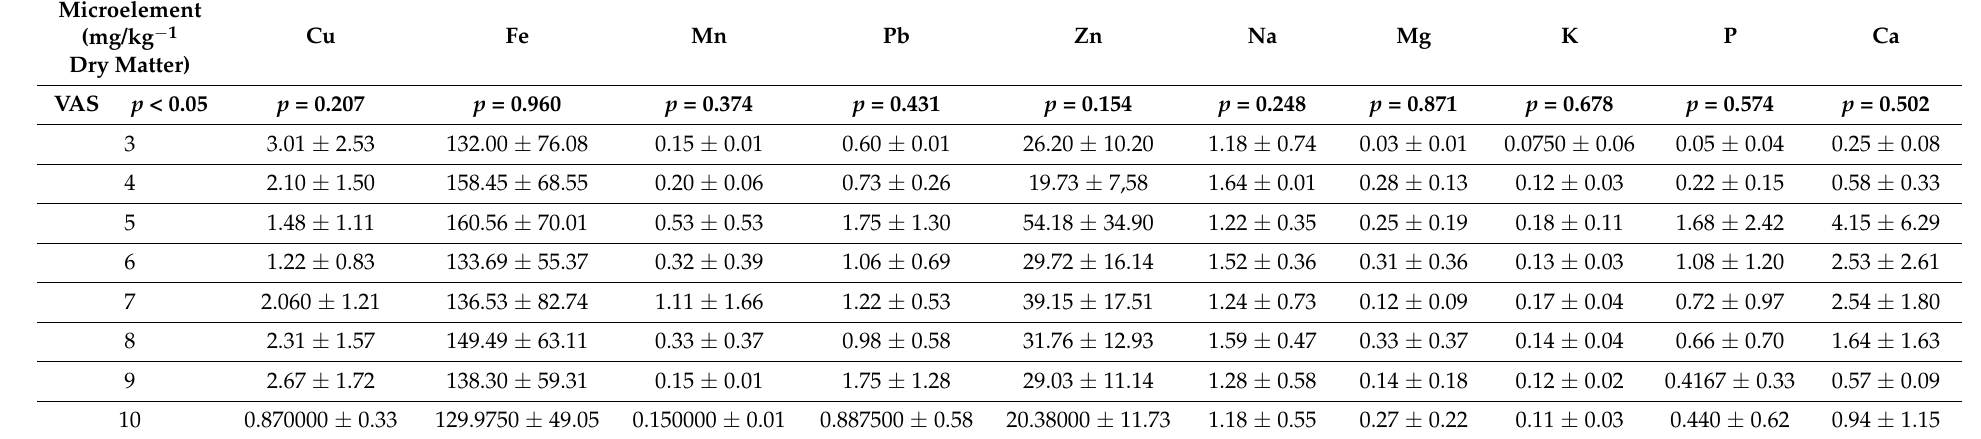
Table 6. Concentrations of selected elements in degenerated intervertebral discs, depending on pain intensity.